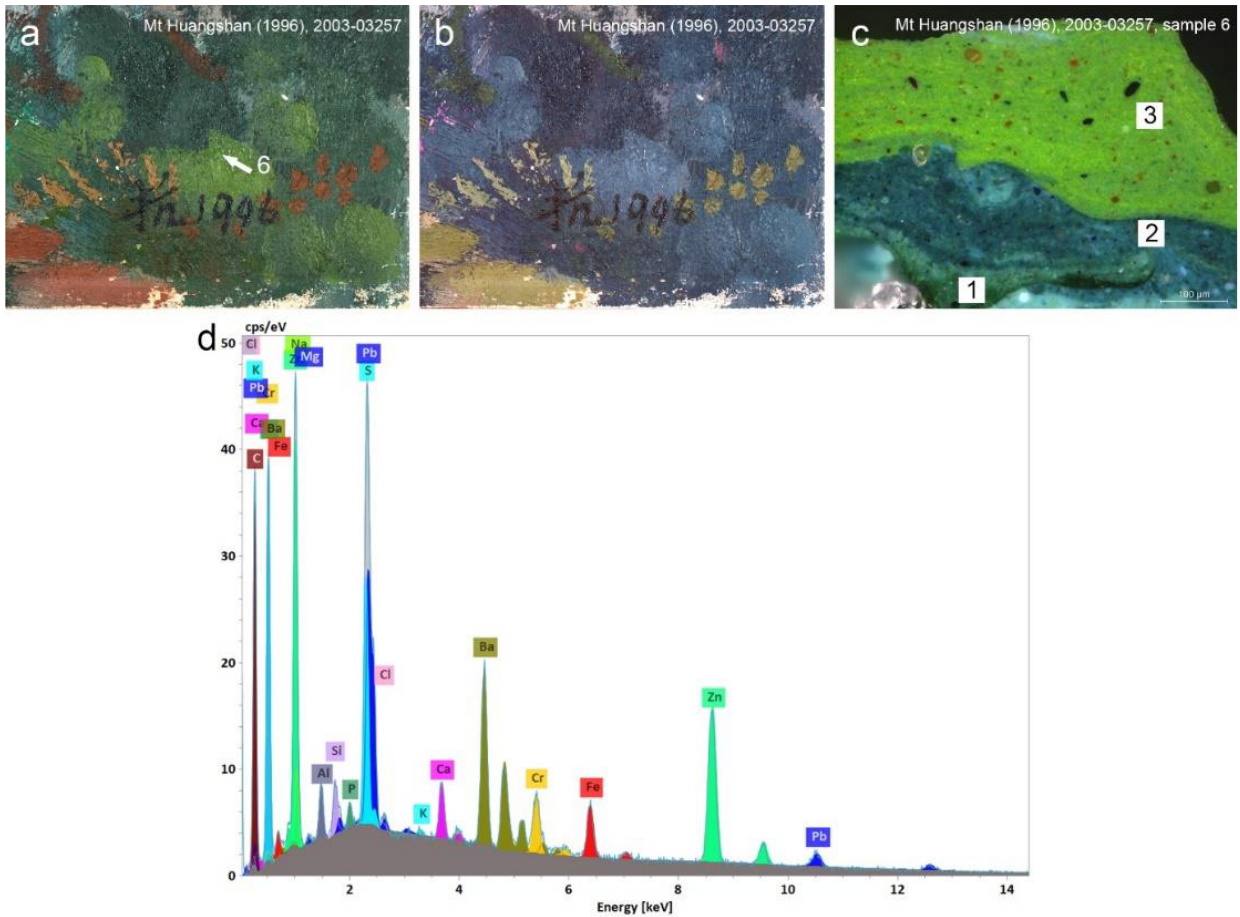
Figure 16. Detail of Mount Huangshan , 1996, photographed in VIS showing the extraction spot for sample 6 ( a ) and IRFC image of the same area ( b ). Optical microscopy image of the cross-section of the sample 6 at 200× magnification. Numbers indicate different layers of the paint structure ( c ). Corresponding SEM-EDS spectra of the green paint from layer 3 of sample 6 extracted from the sampling spot ( d ). A green colour recorded as blue in IRFC and the high concentration of Fe in the layer 3 suggested a presence of Prussian blue, which when combined with chrome yellow (assumed by strong Cr and Pb signals), resulted in the green hue of the layer.